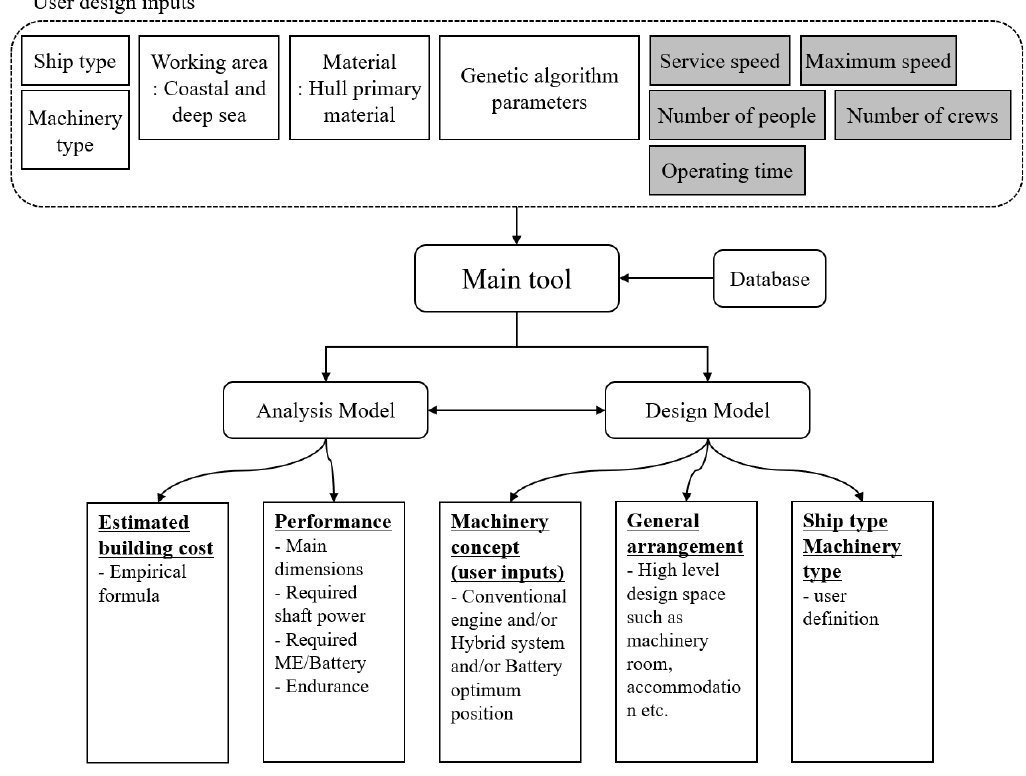
Figure 11. The process of the design tool.